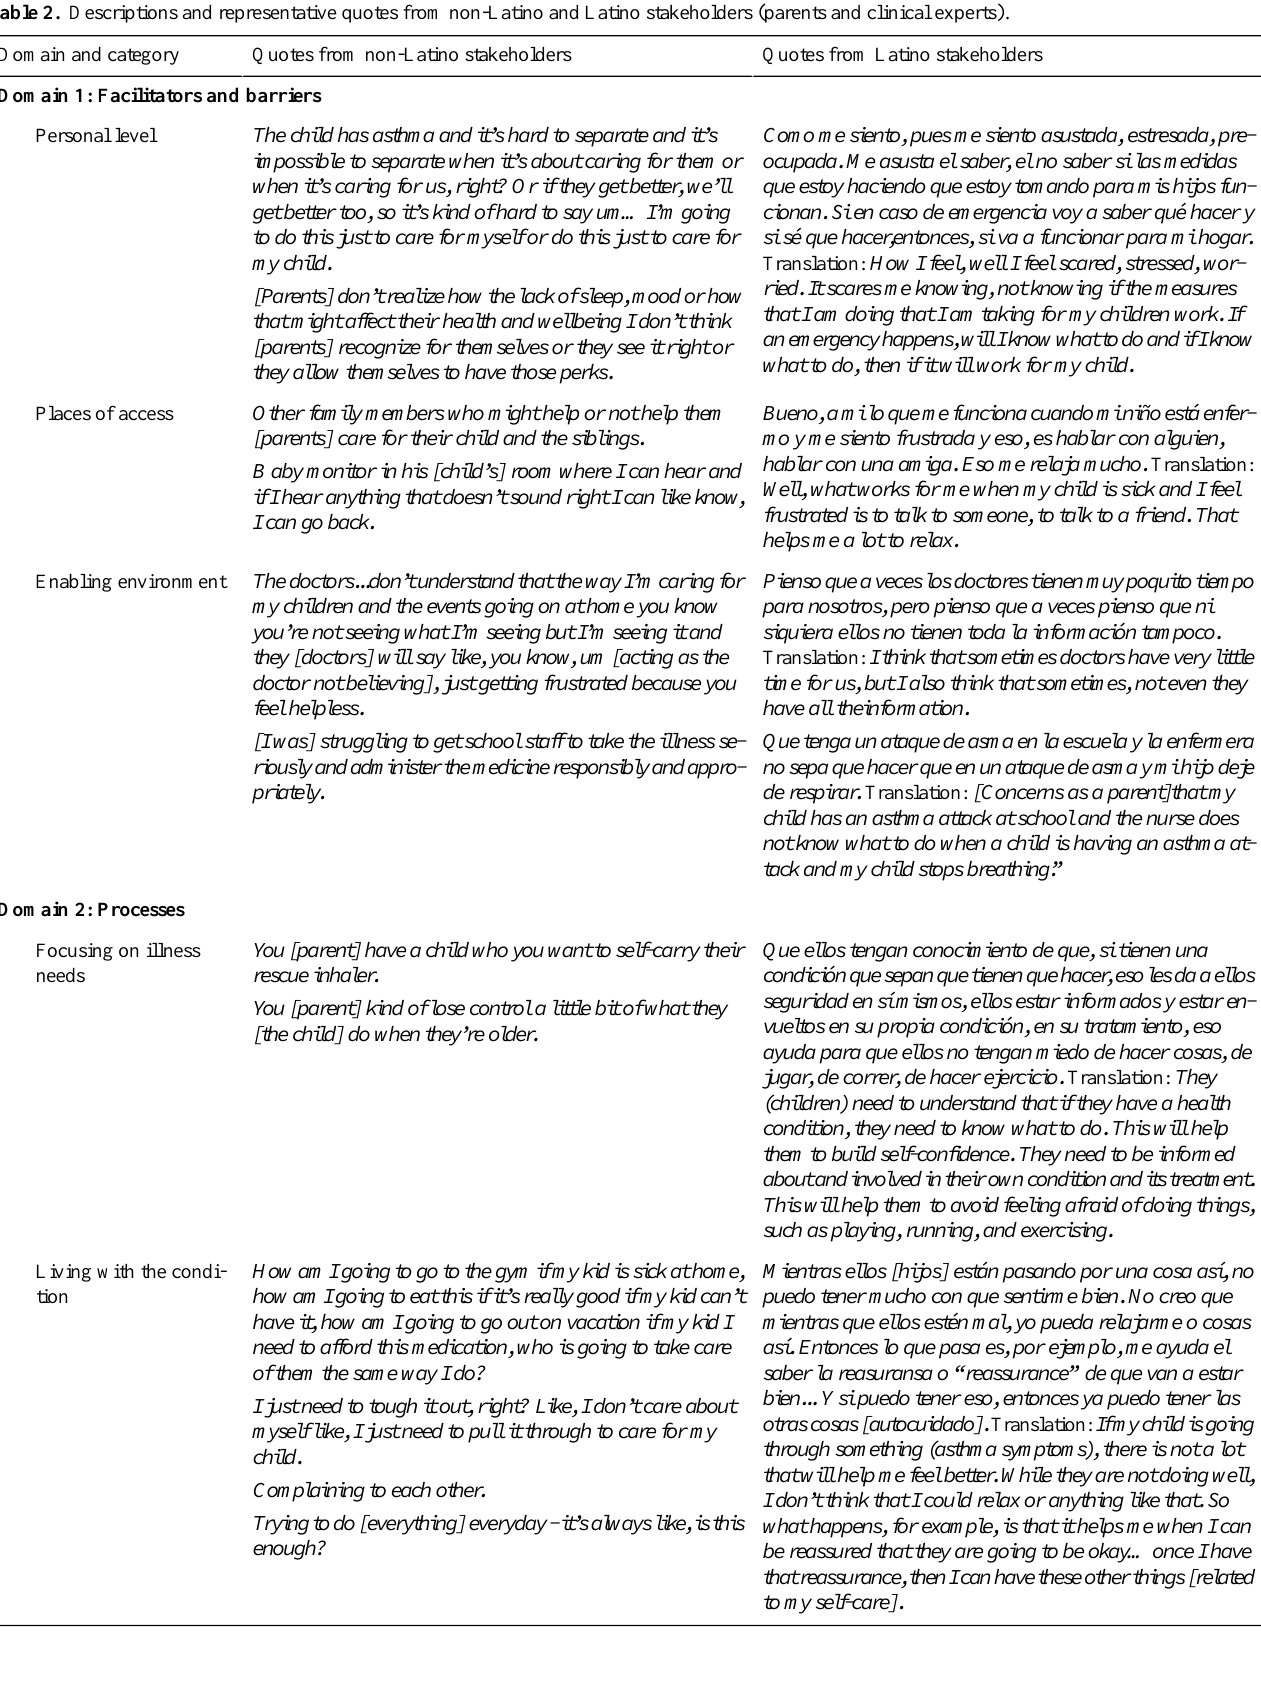
Table 2. Descriptions and representative quotes from non-Latino and Latino stakeholders (parents and clinical experts). Domain 1: Facilitators and